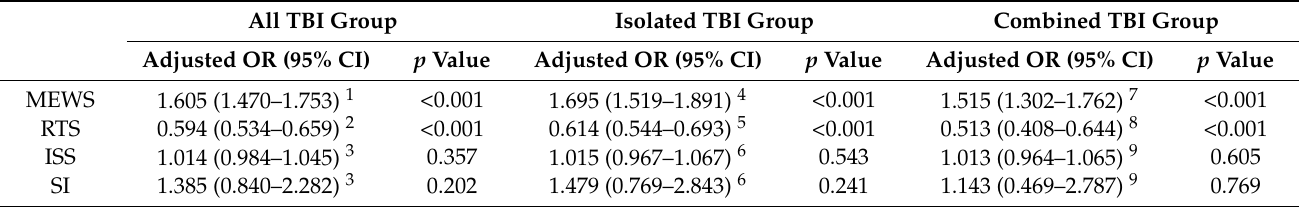
Table 7. Multivariate logistic regression analysis of MEWS, RTS, ISS, and SI for predicting in-hospital mortality in TBI 1